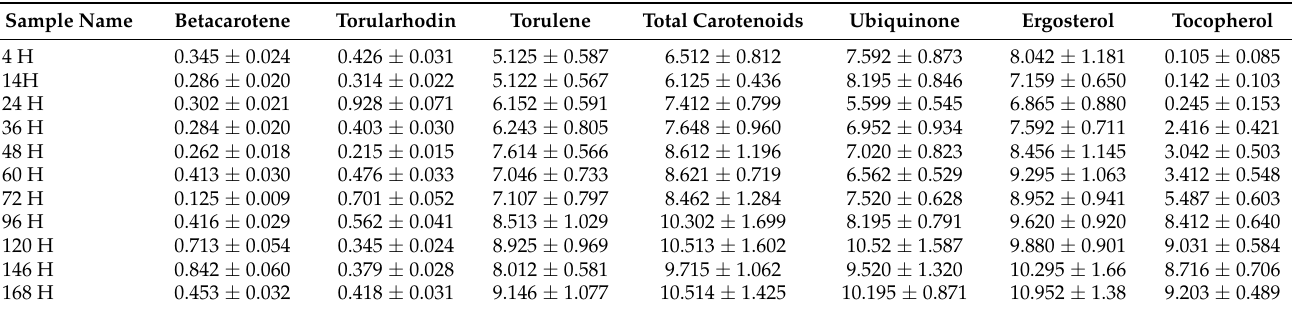
Table 8. HPLC analysis of bioreactor cultivation of Rhodotorula toruloides cultivated on coffee oil and glycerol with lipase induction. Productions are listed in mg/g of cell dry